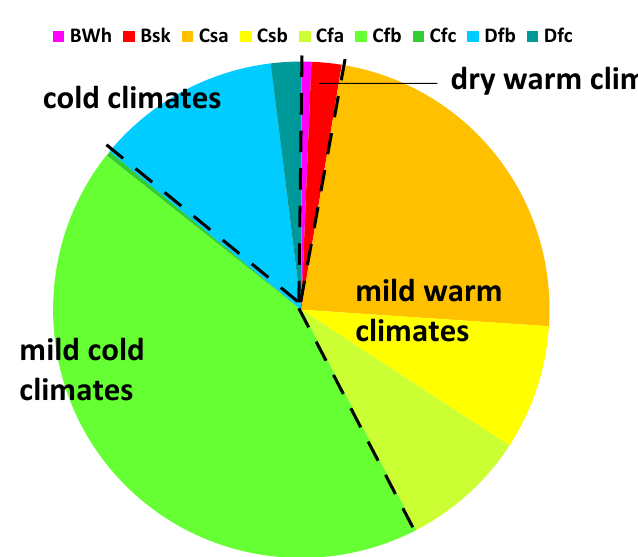
Figure 4. Subdivision of climate conditions based on the Köppen-Geiger scale for the selected locations in Europe.